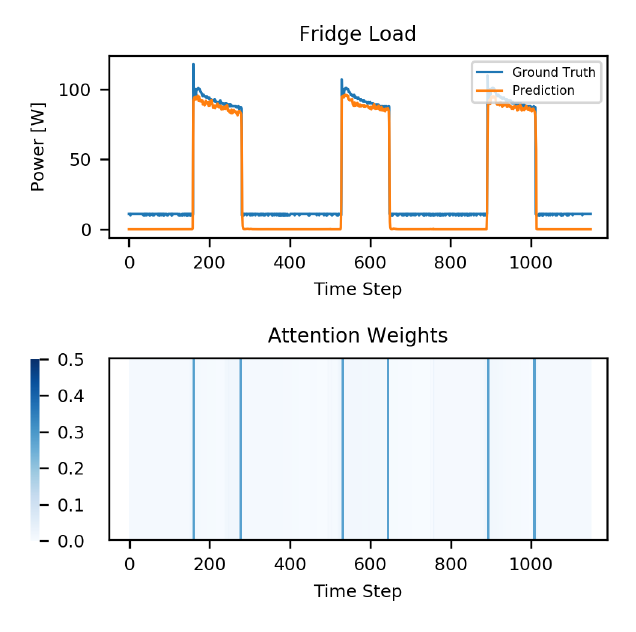
Figure 6. UK-DALE fridge load and the heatmap of the attention weights at 6 s resolution.